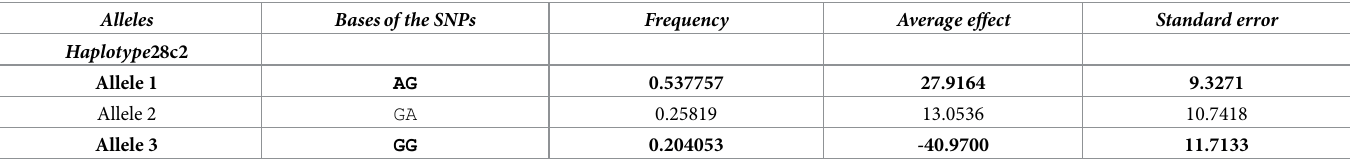
Table 4. Frequency, average effect, and respective standard error of the haplotype alleles located in the MBL-1 gene.